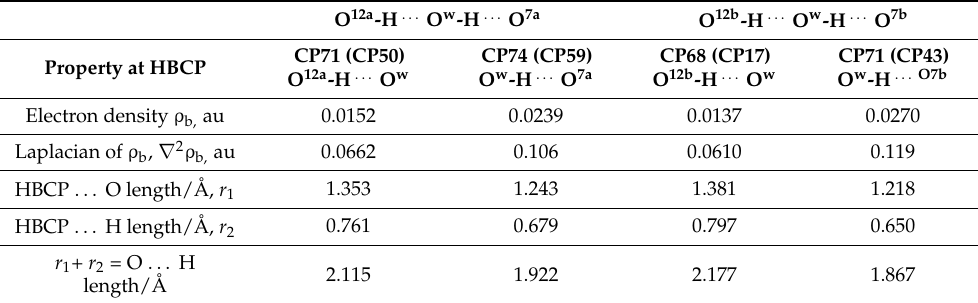
Figure 7. The electron density contour of the O 7b -O w -O 12b complex (thin black lines) and BCP (3,-1) (blue dots). O 12b , O 7b , and O w are oxygen atoms from the pseudo-bile acid residues and water, respectively. Thin gray lines correspond to the gradient of the electron density. Table 2. Electron density, Laplacian of the electron density, and lengths involved in the formation of hydrogen bonds of the two semi complexes: O 12a -H ... O w -H ... O 7a and O 12a -H ... O w -H ... O 7a .